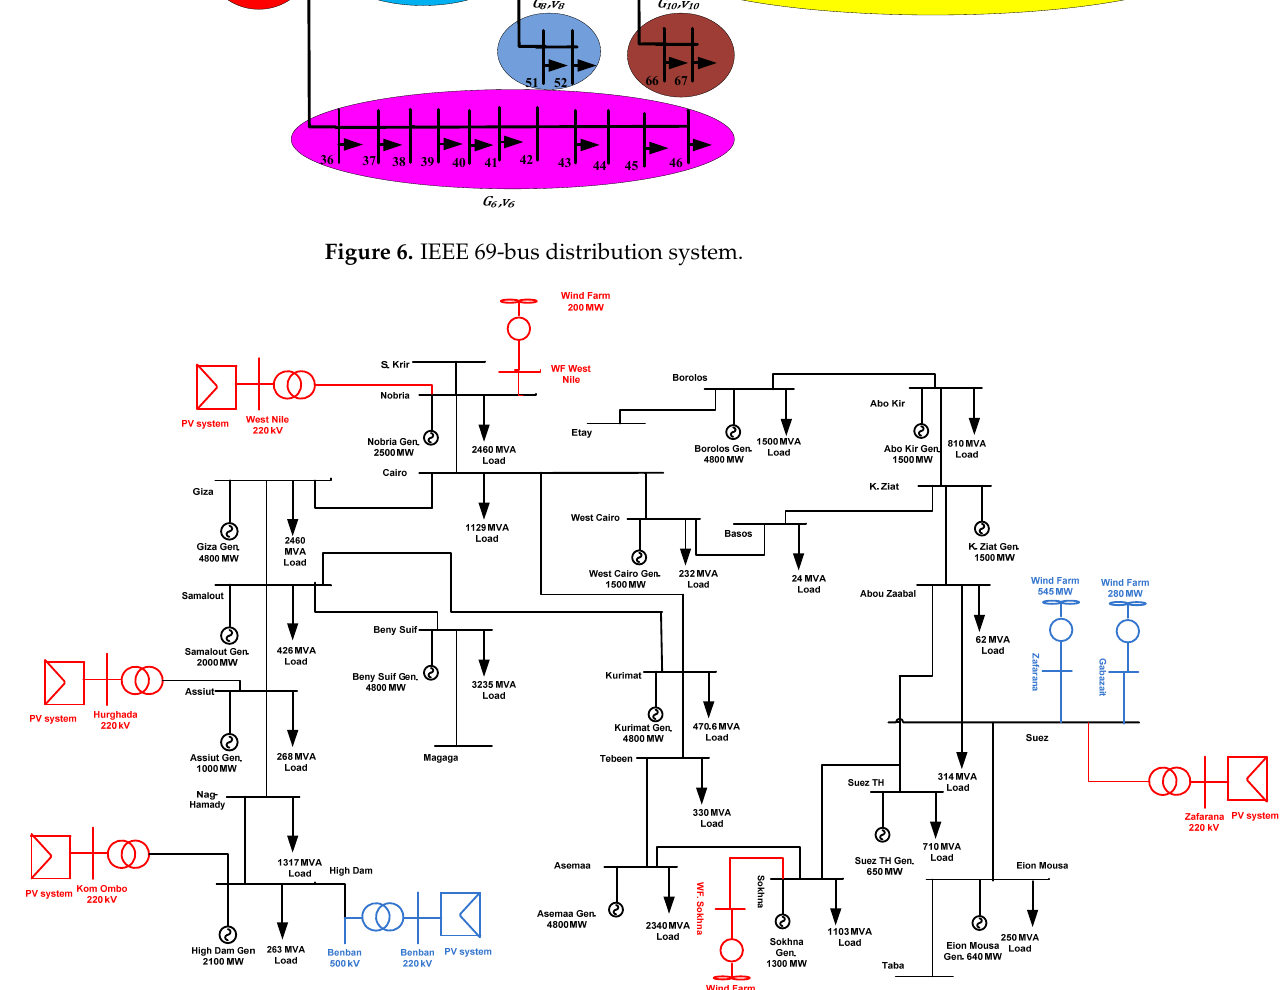
Figure 7. Single line diagram of the 25-bus 500 kV Egyptian power system.